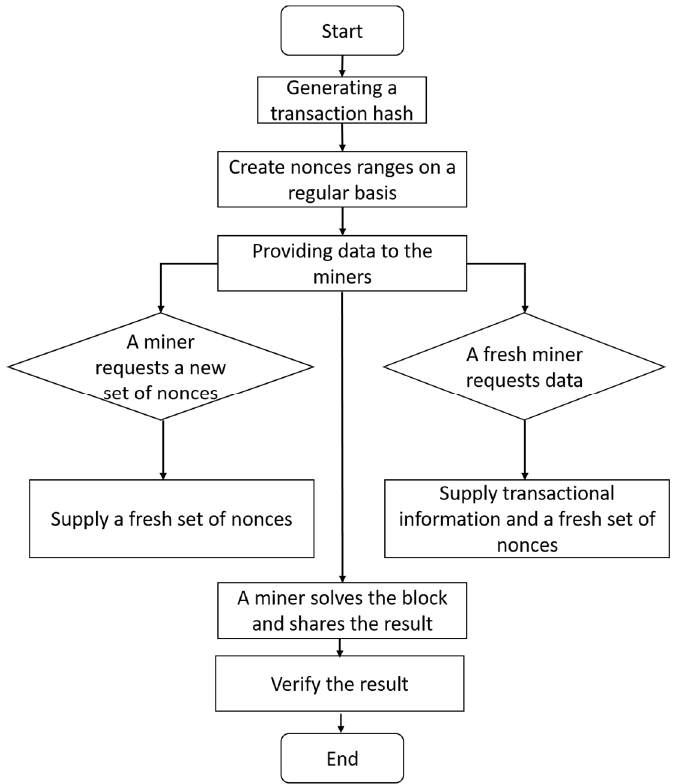
Figure 3. The process of a miner acting as a manager.